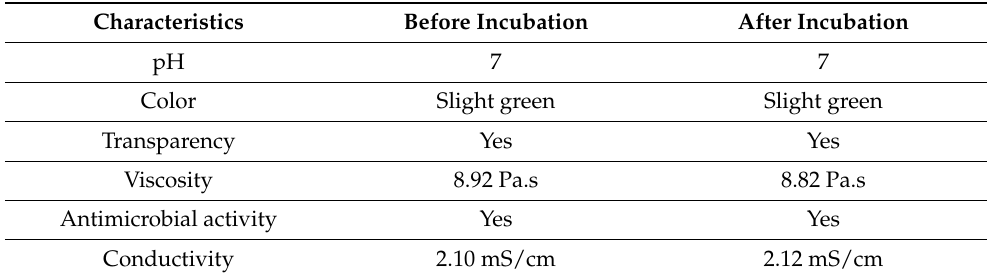
Table 3. Different characteristics of the selected formulation (S1) before and after the incubation